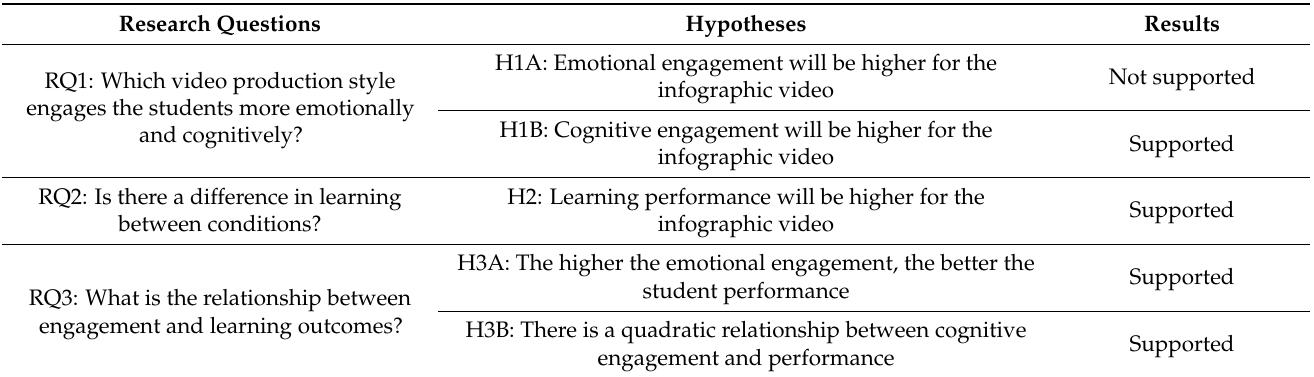
Table 5. Summary of research questions, hypotheses, and